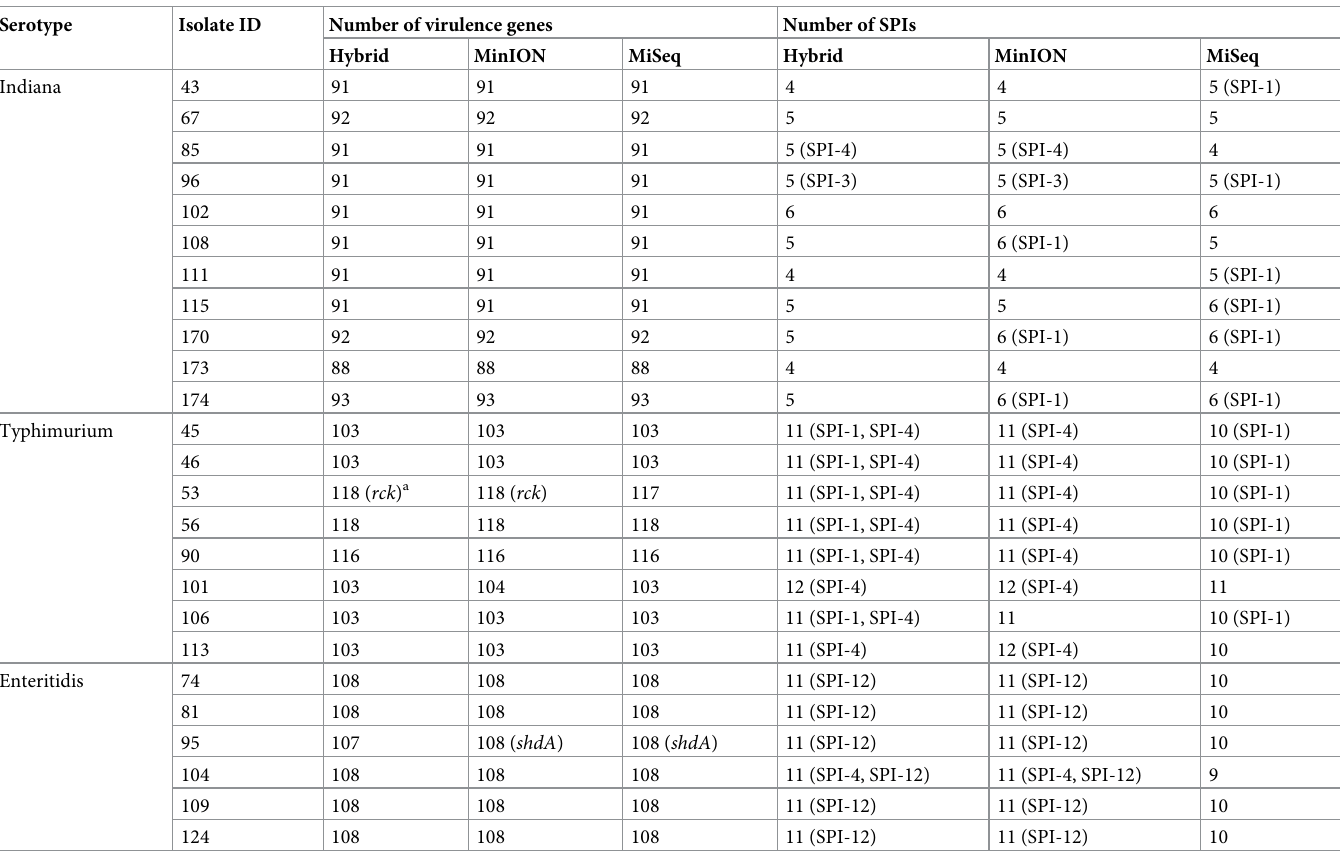
Table 6. Numbers of virulence genes and Salmonella pathogenicity islands (SPIs) of Salmonella isolates, as predicted based on their hybrid, MinION, and MiSeq assemblies.